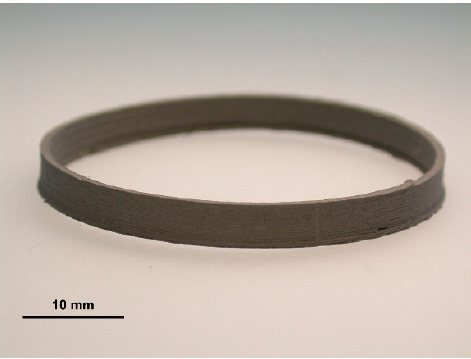
Figure 2. Photograph of printed ring using the in-house designed feedstock. The diameter of the ring is 40 mm.